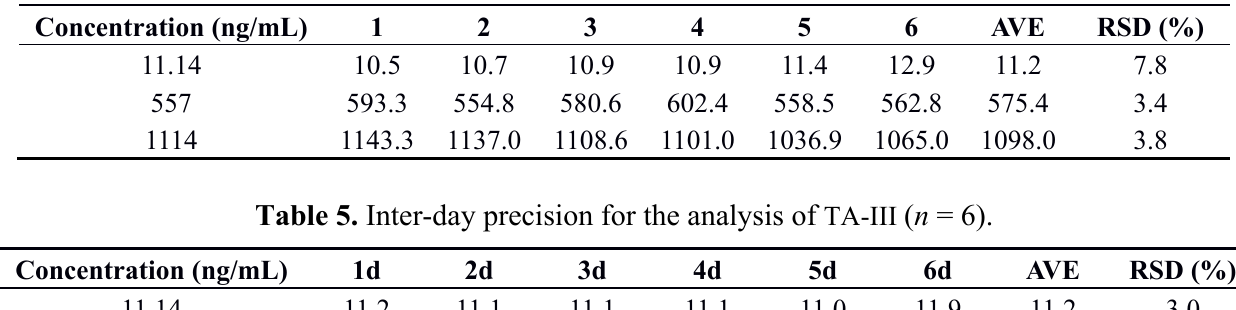
Table 4. Intra-day precision for the analysis of TA-III ( n = 6).